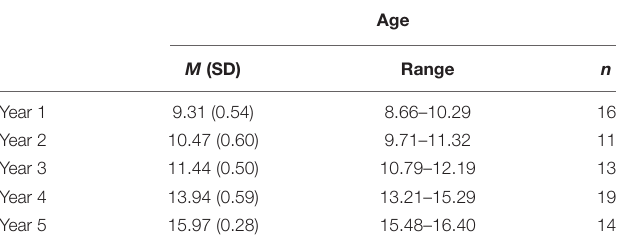
TABLE 1 | Descriptive statistics for child age at MRI scanning